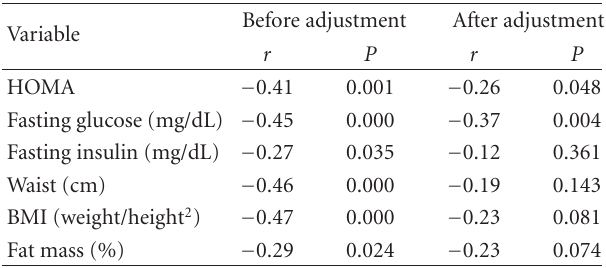
Figure 1: Correlation between the results of the [ 13 C]glucose breath test and the Homeostasis Model Assessment (HOMA). Table 2: Correlation of δ 13 CO 2 (‰) with variables associated with insulin resistance, before and after adjustment for total CO 2 .